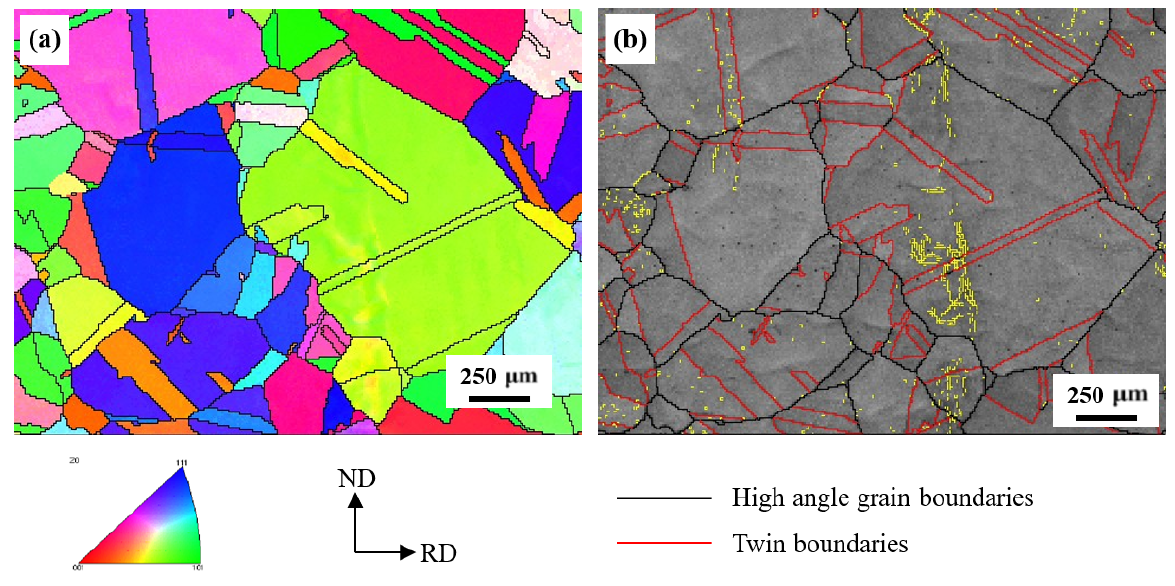
Figure 3. EBSD crystallographic analyses of the steel before deformation. ( a ) IPF map, showing grain orientations. ( b ) IQ map containing general high angle grain boundaries and Σ 3 twin